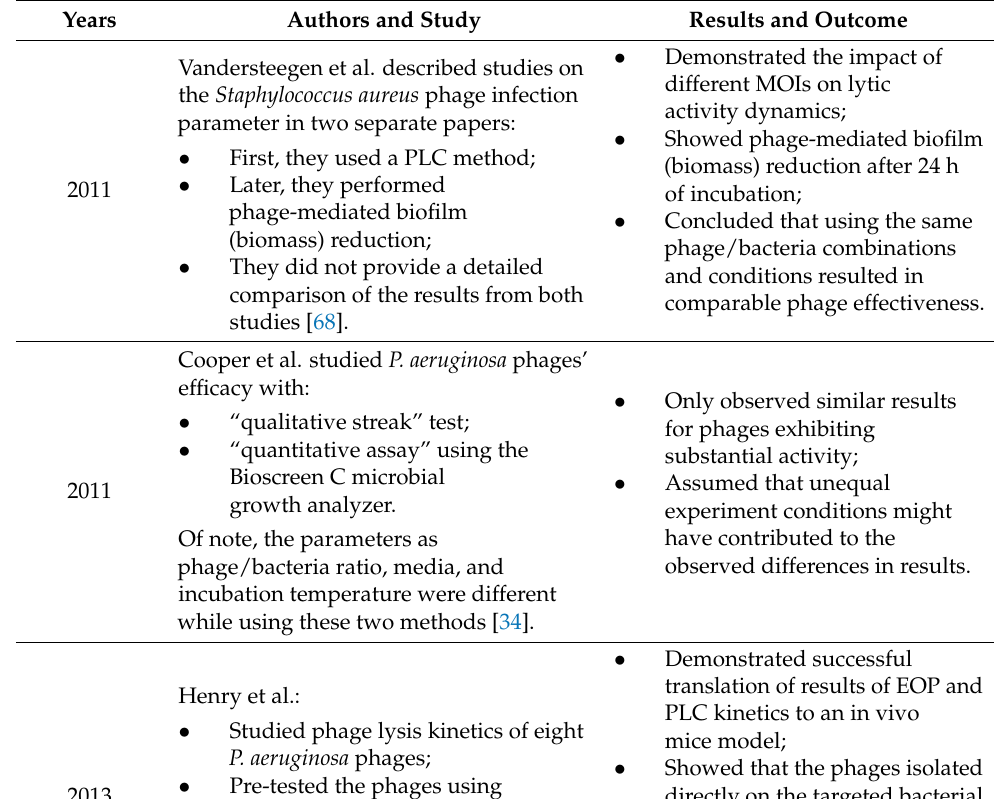
Table 1. Cont. Years Authors and Study Results and